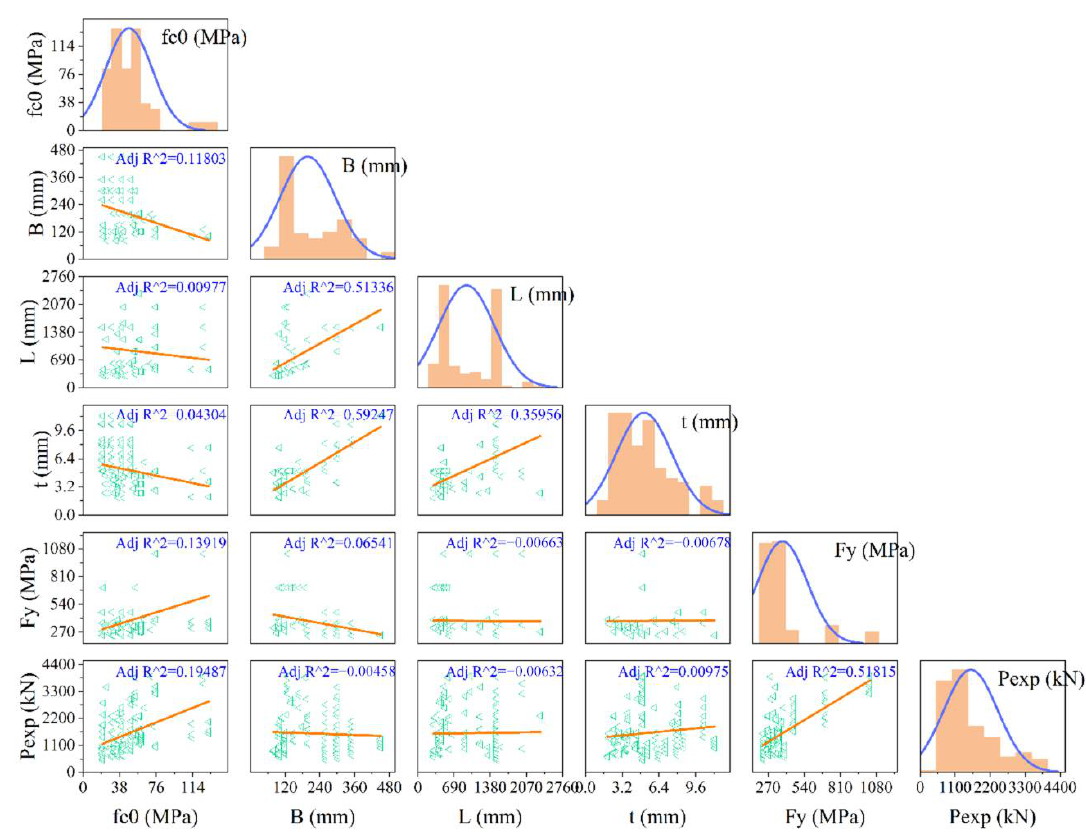
Figure 8. Correlation matrix for the input and output variables.